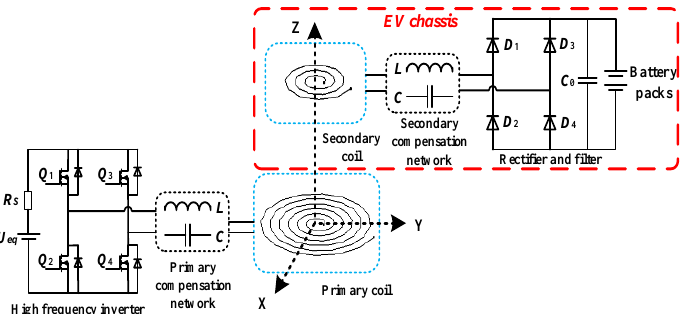
Figure 1. Schematic diagram of an inductive power transfer (IPT) system.